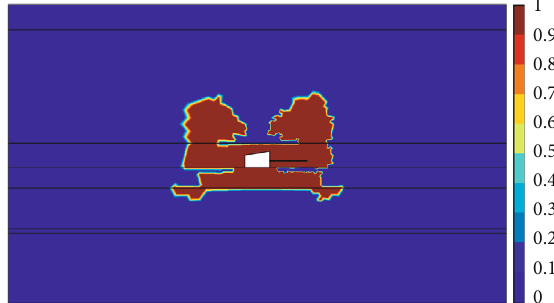
Figure 10: Distribution of plastic zone on roadway surrounding rocks.